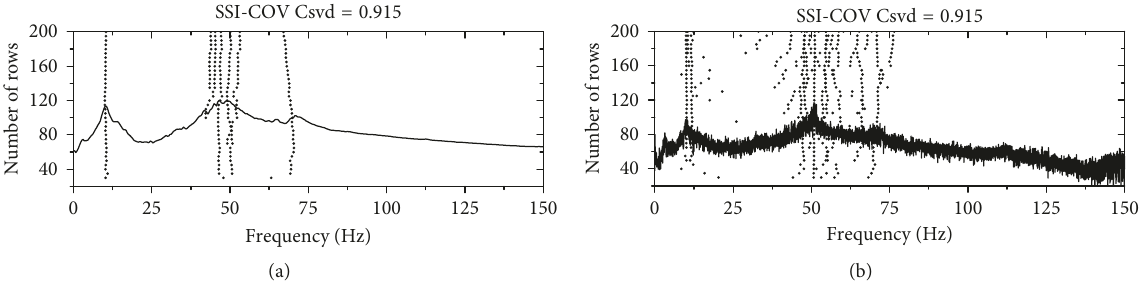
Figure 6: The comparison of the stability diagram of the data collected at daytime: (a) NExT-SSI-COV method; (b) traditional SSI-COV